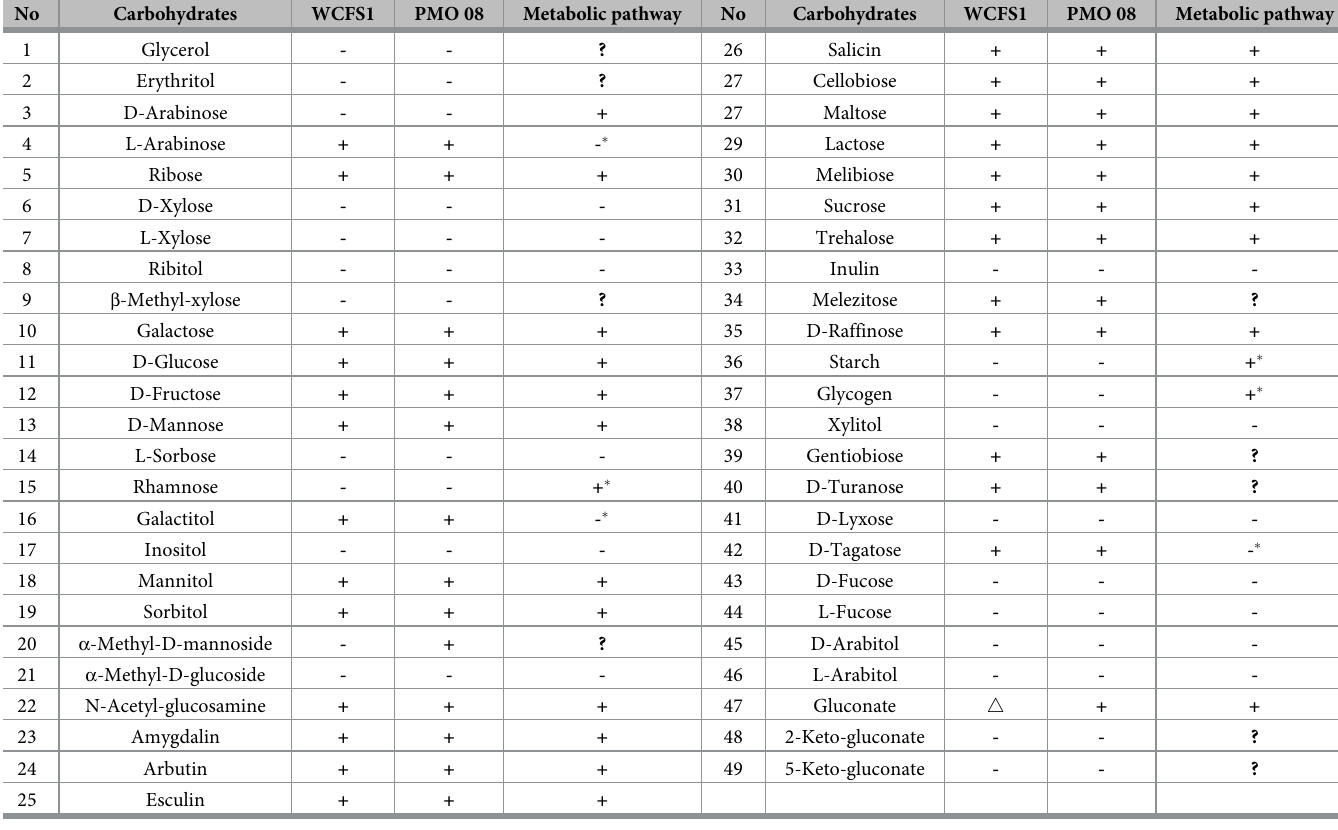
Table 7. Carbohydrate utilization profiles of Lactiplantibacillus plantarum PMO 08 analyzed by in vitro and in silico